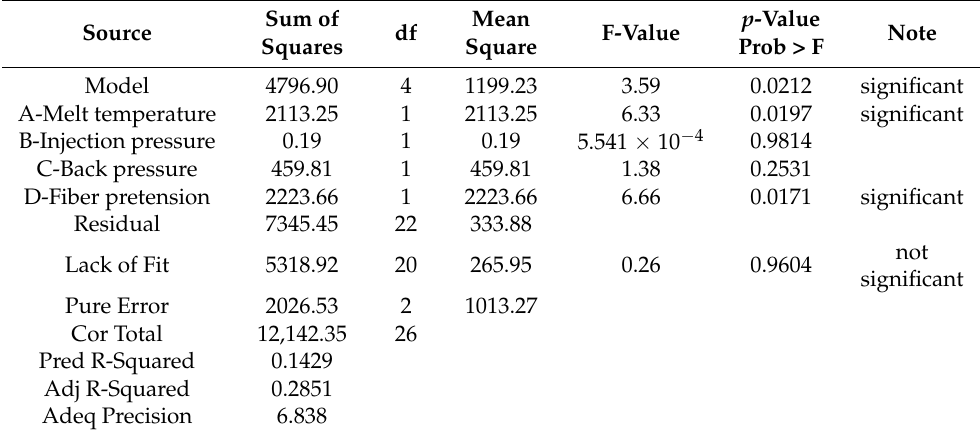
Table 6. Initial ANOVA for impact strength.